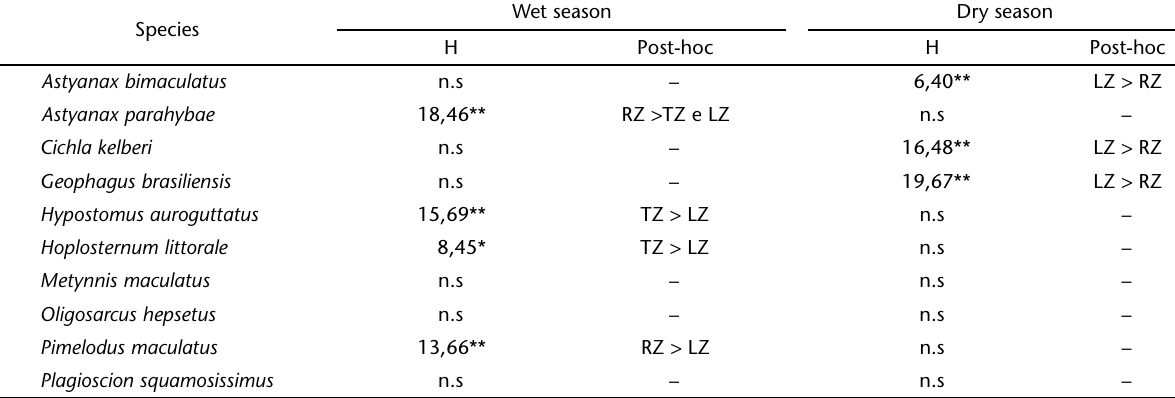
Table II. Results of Kruskall-Wallis (H) comparisons for numerical abundance of the 10 most numerous fish species among zones: (RZ) riverine, (TZ) transition, (LZ) lentic, for each season. (Post-hoc) Test for multiple comparisons of the mean rank for all groups; (n.s.) no significant; (*) significant (p < 0.05); (**) highly significant (p <